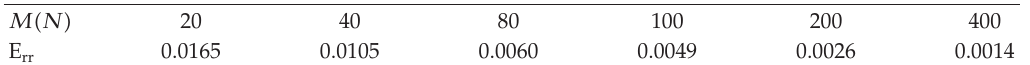
Table 2: Errors in the solutions at t (cid:8) 0 . 8 with number of